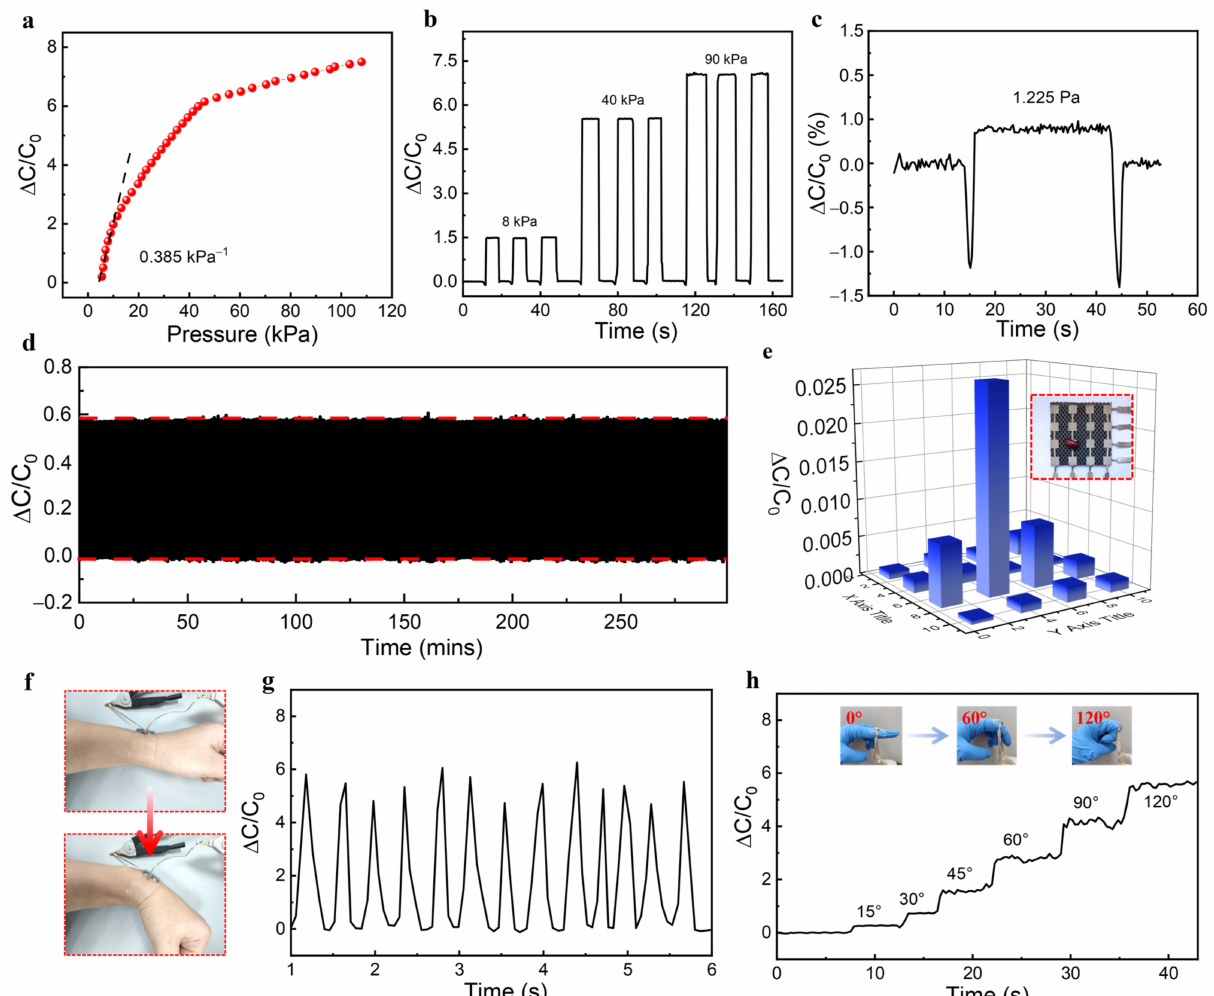
Figure 3. Pressure-sensing performance of the BAFC sensor: ( a ) relative capacitance response and sensitivity of the BAFC sensor; ( b ) capacitive response of the sensor for different loads of 8, 40, and 90 kPa; ( c ) ultra-light pressure responses; ( d ) durability of the capacitance response of the BAFC sensor to 2000 cycles under a loading pressure of 6 kPa; ( e ) pressure spatial mapping of a red bean; ( f , g ) capacitance change of the BAFC sensor according to wrist bending motion; ( h ) representative capacitance signal during the bending and unbending of finger to angles of 15, 30, 45, 60, 90, and 120 ◦